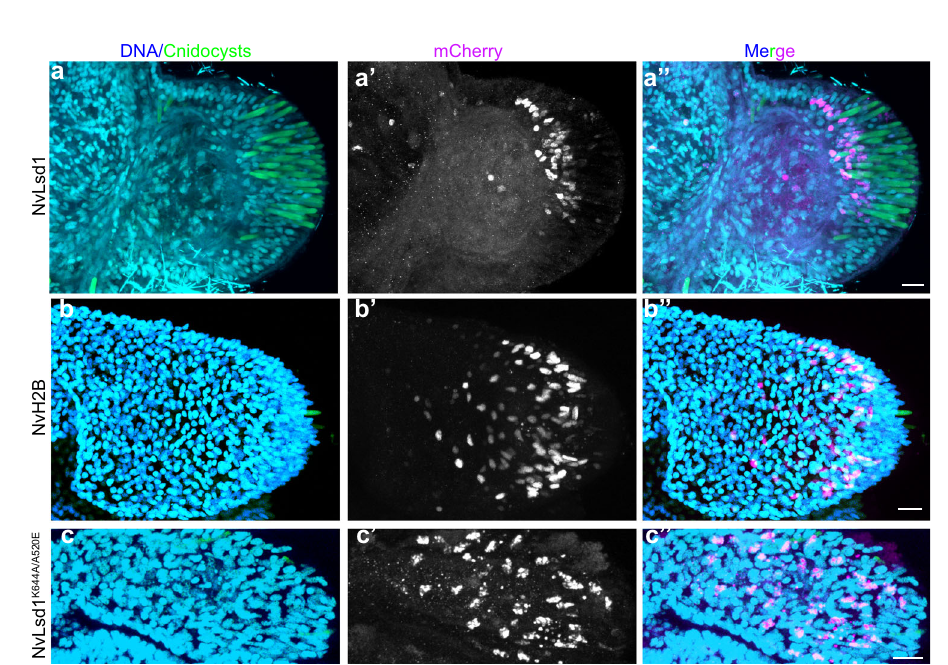
Fig. 6 NvLsd1 is required cell autonomously for cnidocyte differentiation. a – c Immunostaining on NvLsd1 − / − animals injected with NvPOU4 : NvLsd1- mCherry (n = 9) ( a ), NvPOU4 : NvH2B-mCherry (n = 16) ( b ) or NvPOU4 : NvLsd1 K644A/A520E -mCherry (n = 6) ( c ). DNA is shown in blue, DAPI + cnidocysts in green and mCherry in magenta. Experiments were performed three times independently and the total number of animals analysed for each condition are indicated (n). Scale bars: 10 μ